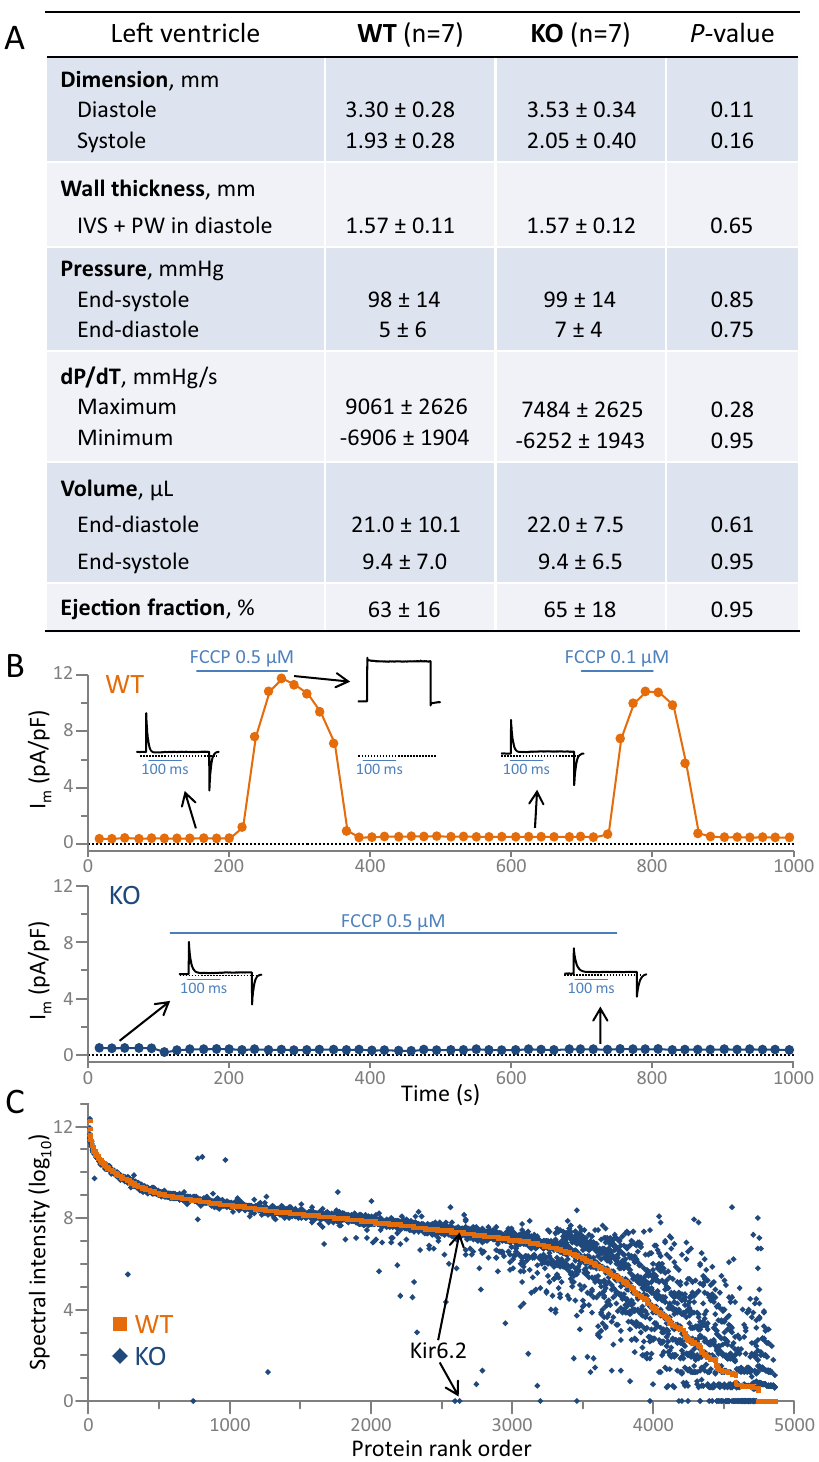
Figure 1. K ATP channel Kir6.2 knockout deviates from wildtype at cardiac proteome level. ( A ) Cardiac ultrasound, left ventricular pressure, and left ventricular pressure–volume conductance showed equivalent chamber size/volume, wall thickness (IVS, inter-ventricular septum; PW, posterior wall), as well as systolic and diastolic function in wildtype (WT) and Kir6.2 knockout (KO). ( B ) In voltage-clamped isolated cardiomyocytes, 2-[2-[4-(trifluoromethoxy) phenyl] hydrazinylidene]-propanedinitrile (FCCP) activated outward current in WT (upper panel; tracing representative of 7 cells) but not in KO (lower panel; tracing representative of 6 cells). Plotted recordings are current values measured at the end of 200 ms long cell membrane depolarization from −40 to −20 mV, normalized to cell capacitance. Horizontal bars represent periods of FCCP application. Insets show whole-cell current recordings prior to and following FCCP application at points denoted by arrows. ( C ) Proteome deviation in KO (blue diamonds; n = 10) is evident as a shift up (increased) or down (decreased) compared to WT (orange squares; n = 10). Individual protein abundance is based on mean ion spectral intensity, plotted for the 4846 detected proteins and rank ordered by WT intensity (average of n = 10), with KO intensity (average of n = 10) at the corresponding x-coordinate. The respective positions of Kir6.2 mean spectral intensity in WT and KO are